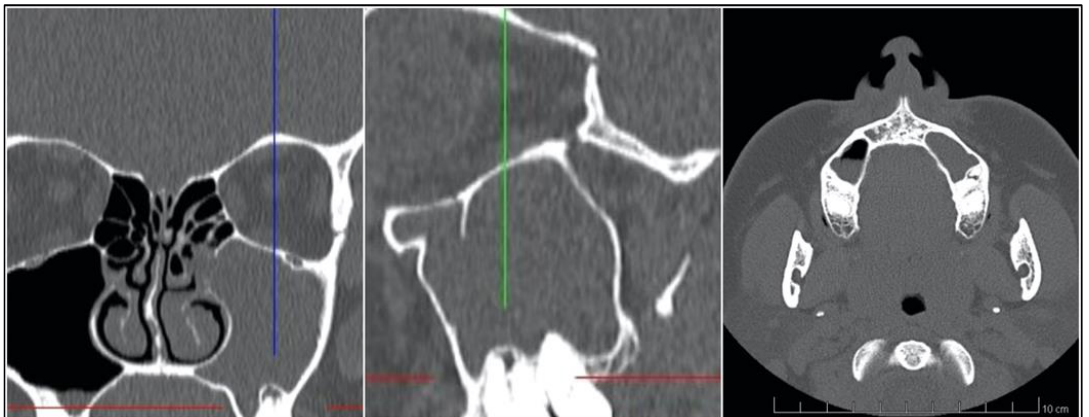
Figure 1. The example of CT scans of odontogenic maxillary sinusitis with a periapical lesion affecting mesio- and distobuccal root of first maxillary molar; from left to right: coronal, sagittal and axial view. Vertical and horizontal lines point the PAL .